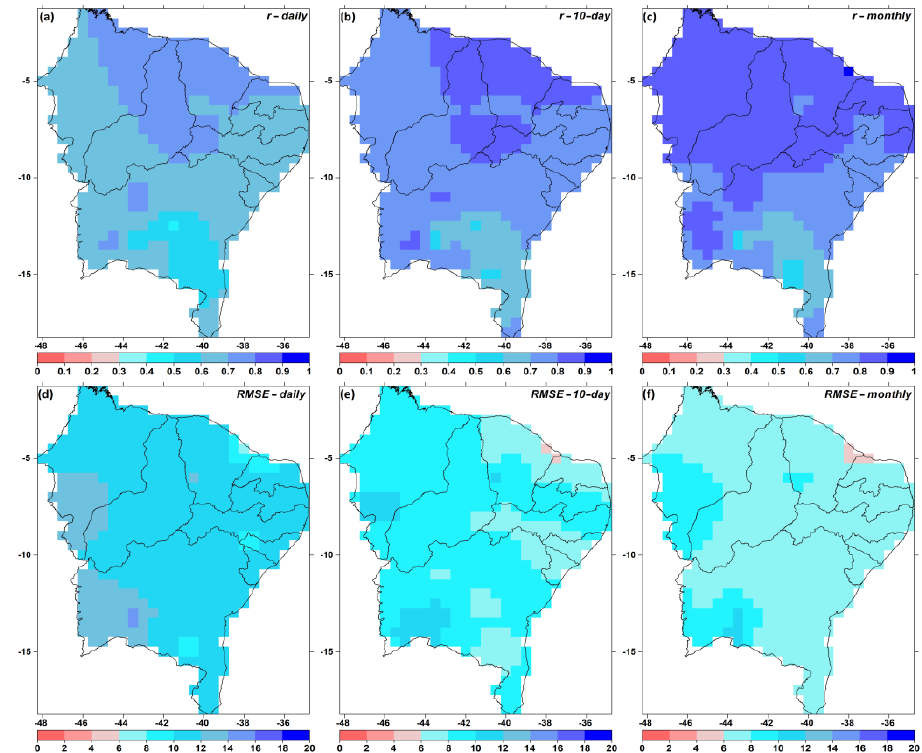
Figure 5. Correlation maps for temperature between imputed and observed data on the daily ( a ), 10-day ( b ) and monthly ( c ) timescales; and RMSE (°C) on the daily ( d ), 10-day ( e ) and monthly ( f ) time-scales.